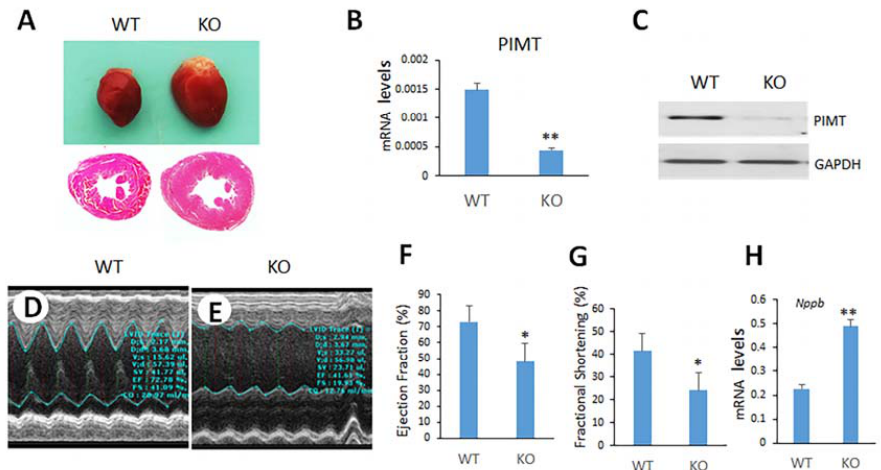
Figure 6. Tamoxifen ‐ inducible cardiac ‐ specific disruption of PIMT (TmcsPIMT − / − ) in adult mice causes dilated cardiomyopathy. Mice were killed 14 days after first tamoxifen injection in the experiments.